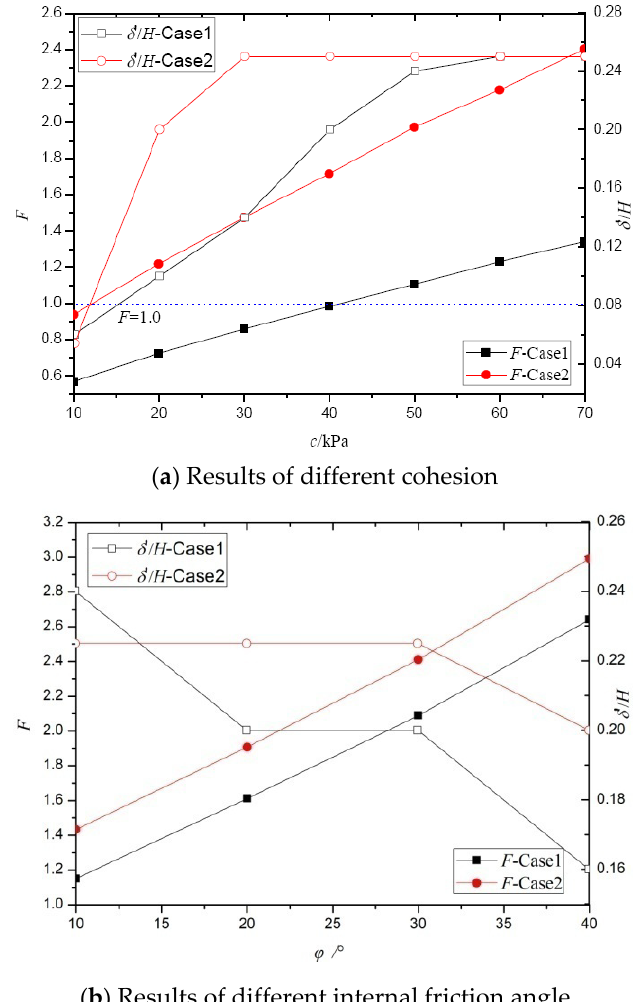
Figure 13. Relationship between safety factor and δ ’ / H.